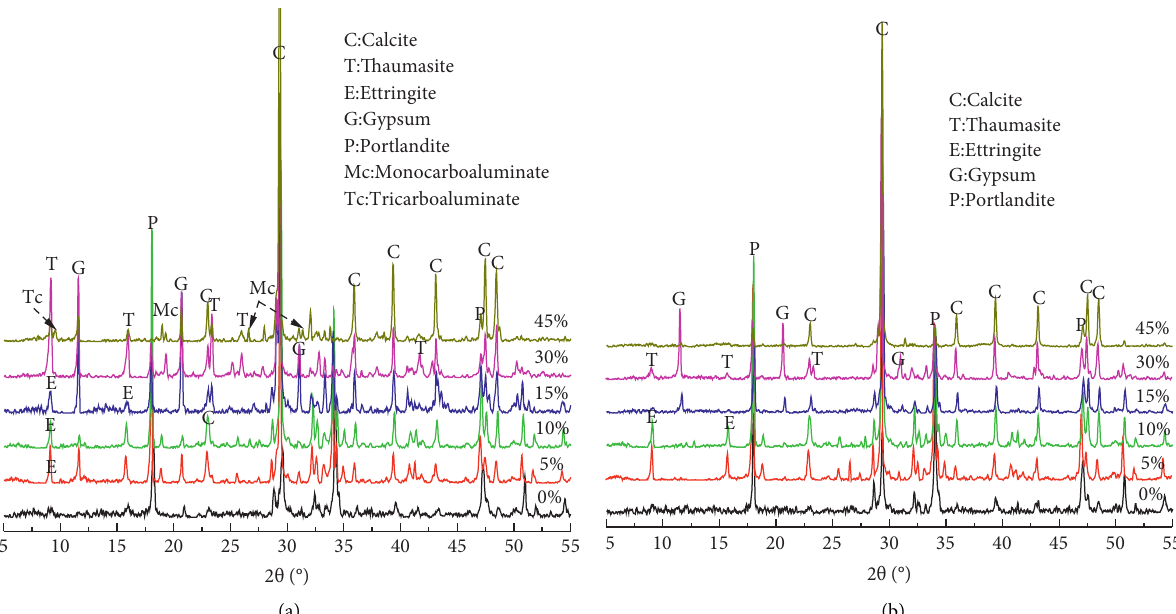
Figure 7: XRD pattern of the cathode surface and anode surface for all specimens at 120 days. (a) Cathode surface and (b) anode surface.